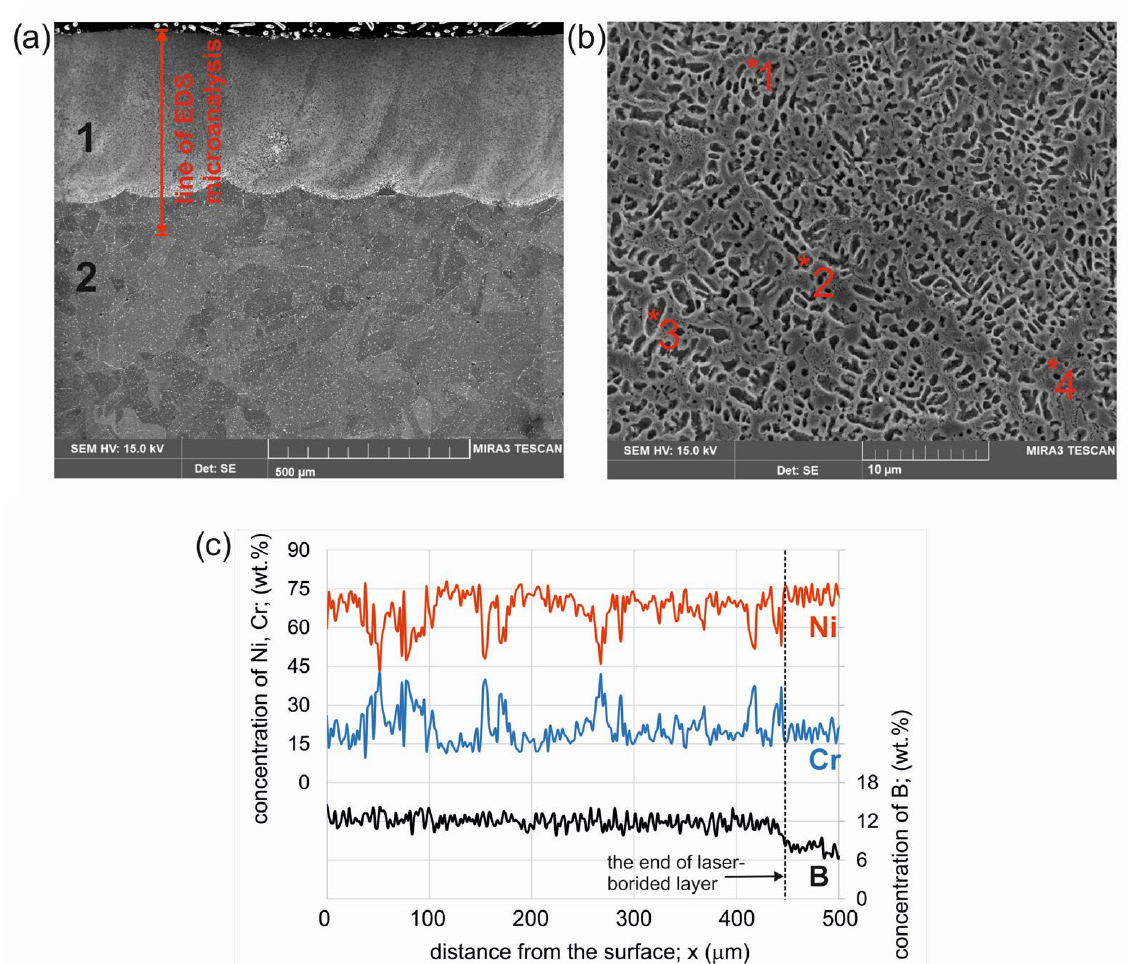
Figure 8. SE image of the cross-sections of the laser borided layers produced on Nimonic 80A alloy using different laser beam power of 1.56 kW: ( a ) entire layer and substrate view; ( b ) details of the microstructure in the re-melted zone with EDS microanalysis points marked; ( c ) the results of linear EDS microanalysis; 1—re-melted zone (laser borided layer); 2—substrate material (Nimonic 80A alloy); *1, *2, *3, *4 — measuring points for EDS microanalysis.